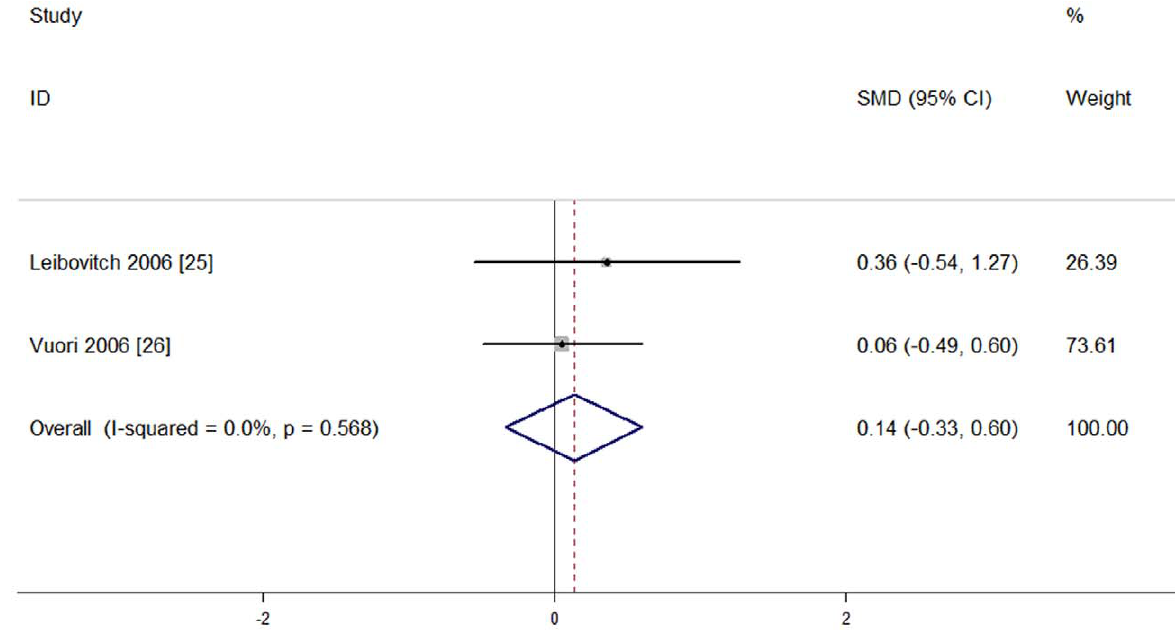
Figure 5. Meta-analysis of postoperative overall color vision.